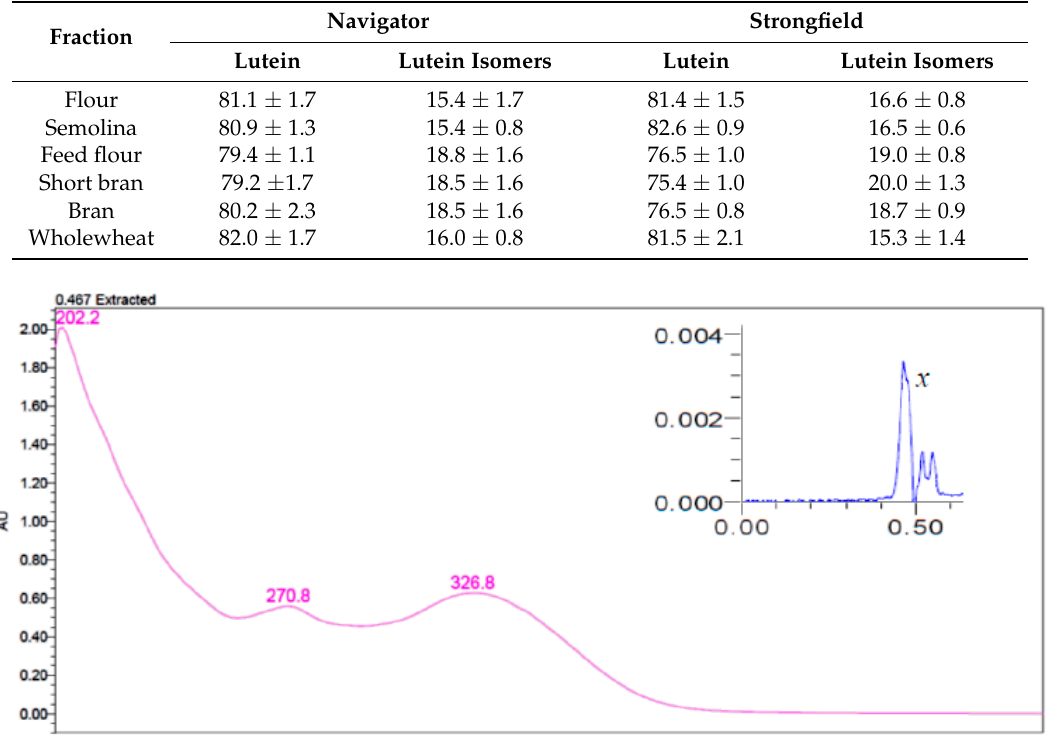
Figure 4. Absorption spectrum of peak x eluted at retention time (Rt) 0.47 in bran, short bran, and flour feed fractions. Table 3. Percentage composition of lutein including unknown compounds in the bran, short bran, and feed flour fractions.